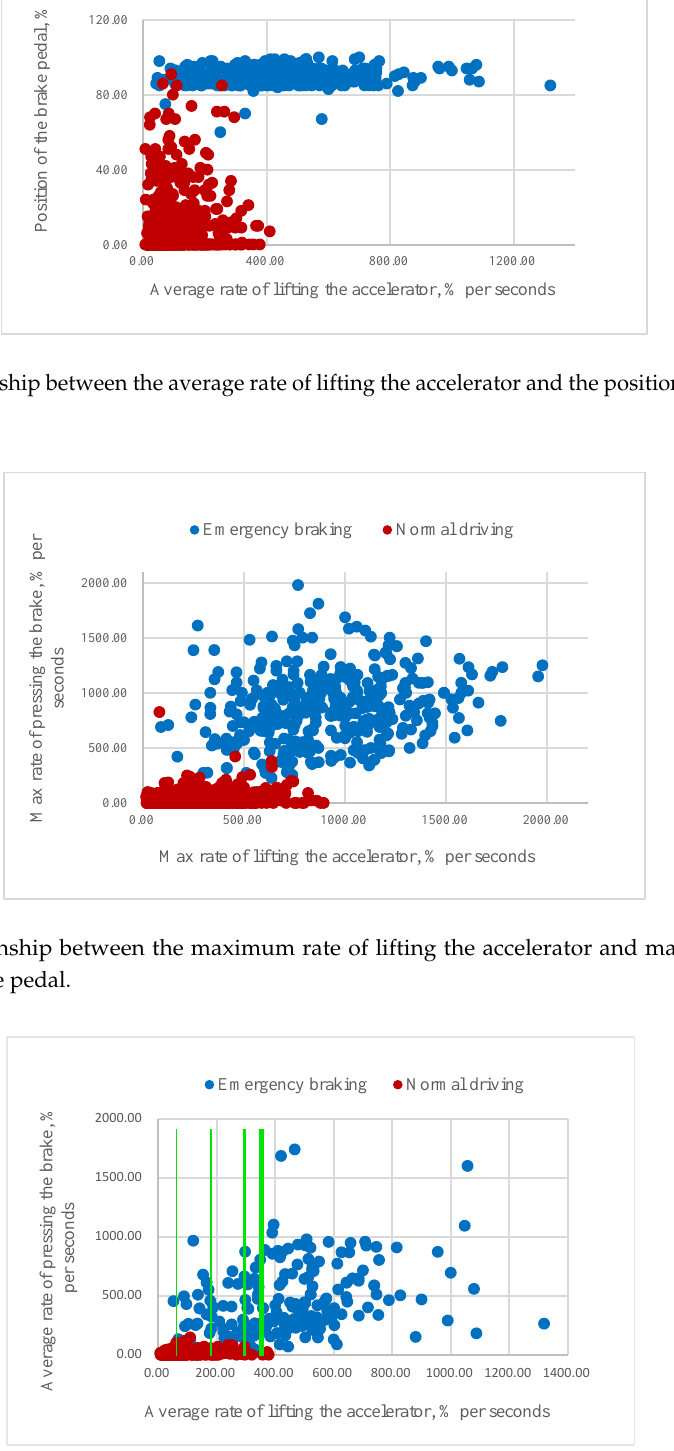
Figure 10. Building process of the threshold classifier for aR feature.